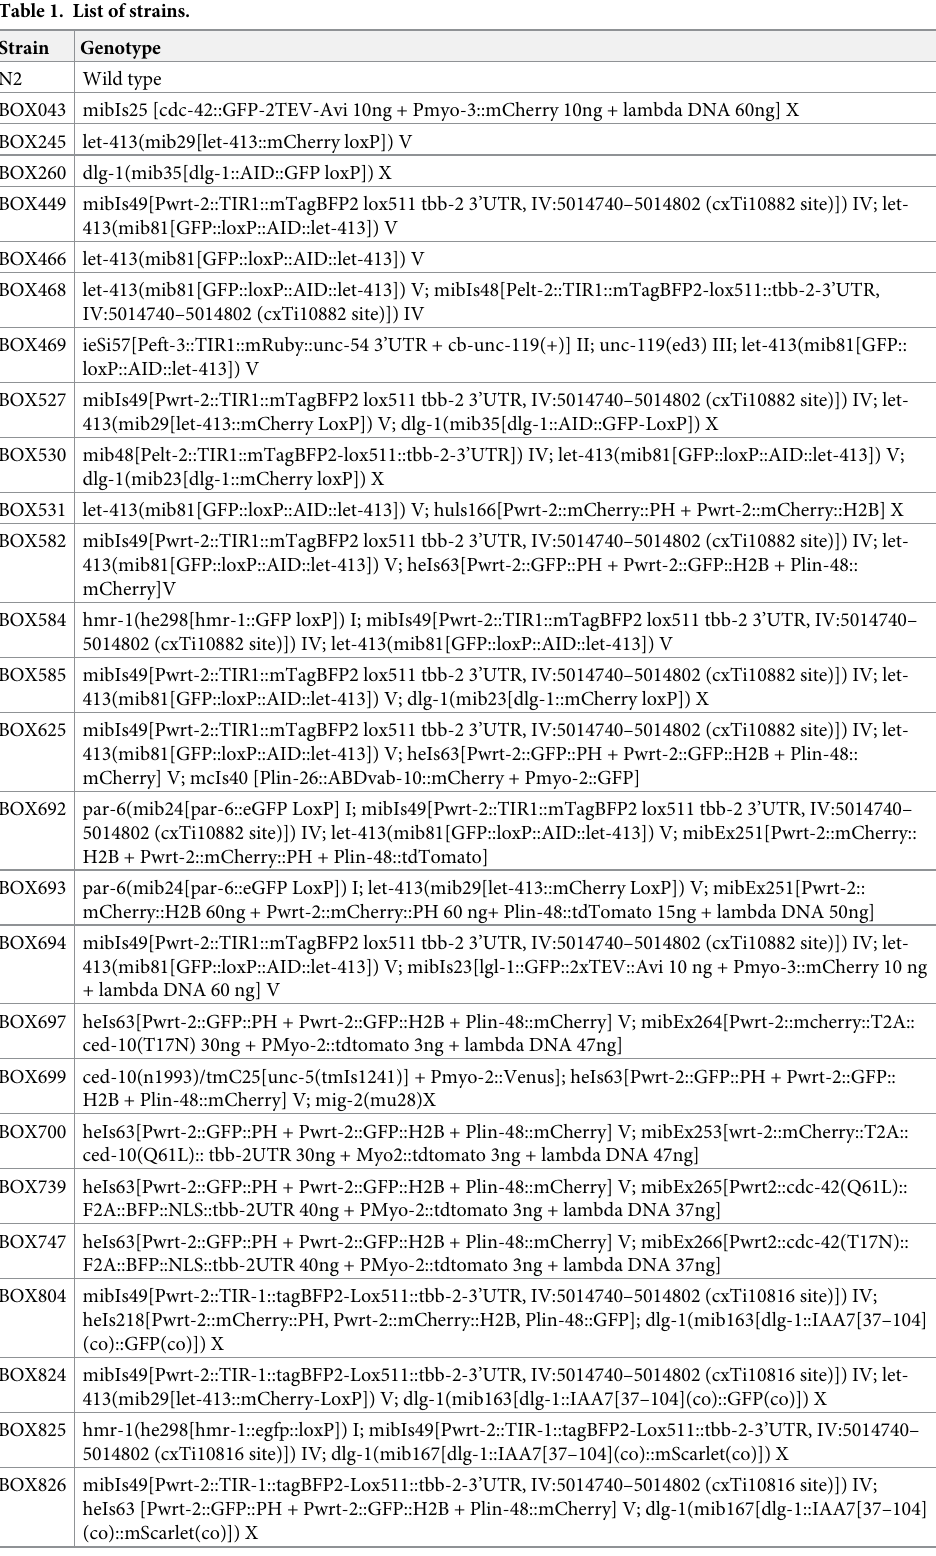
Table 1. List of